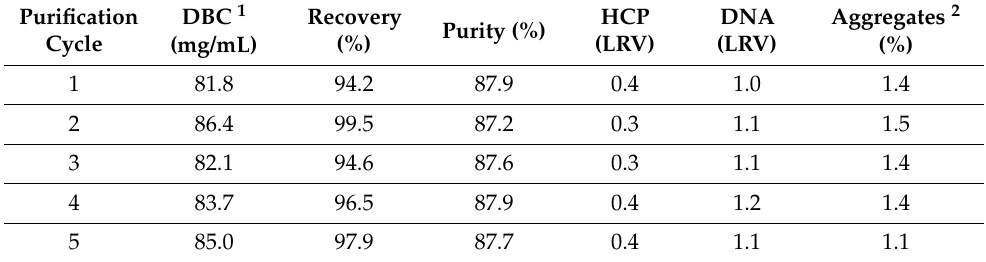
Figure 8. Chromatogram of five consecutive cycles of mAb capture from cell culture fluid with 12 layers of CEX-IDA membrane with 10 mm diameter (0.265 mL membrane volume) at 1 min RT (0.265 mL/min flow rate). Table 3. Results of five consecutive cycles for mAb capture from cell culture fluid. Purification